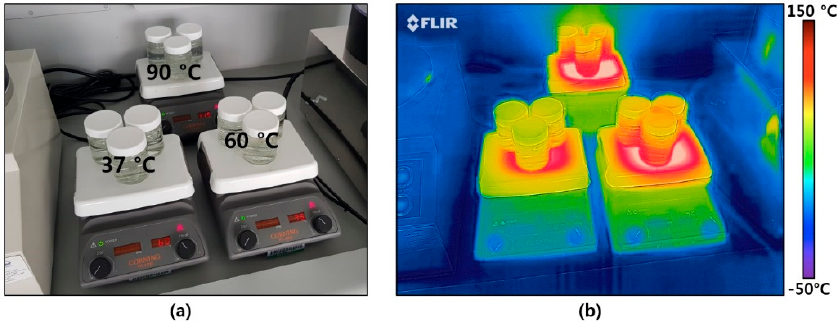
Figure A6. Setup for acceleration tests. ( a ) Photograph of the bottles containing various devices on hot plates that were set up to maintain the temperature of bottle at 37, 60, or 90 °C, respectively; ( b )